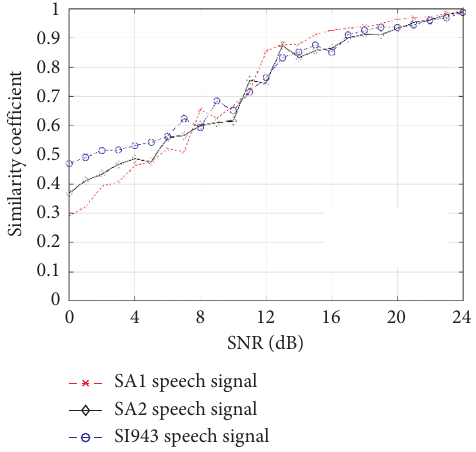
Figure 19: Similarity coefficient of speech signal.